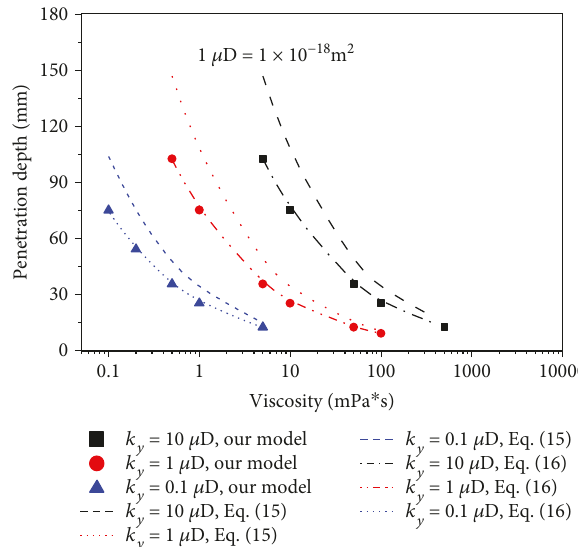
Figure 8: Change of permeation depth with viscosity. The correction coe ffi cients of equation (16) are f μ = 0 0649lg μ + 0 653 = 1 × 10 − 17 m 2 ; f μ = 0 07lg μ + 0 716 for k for k y